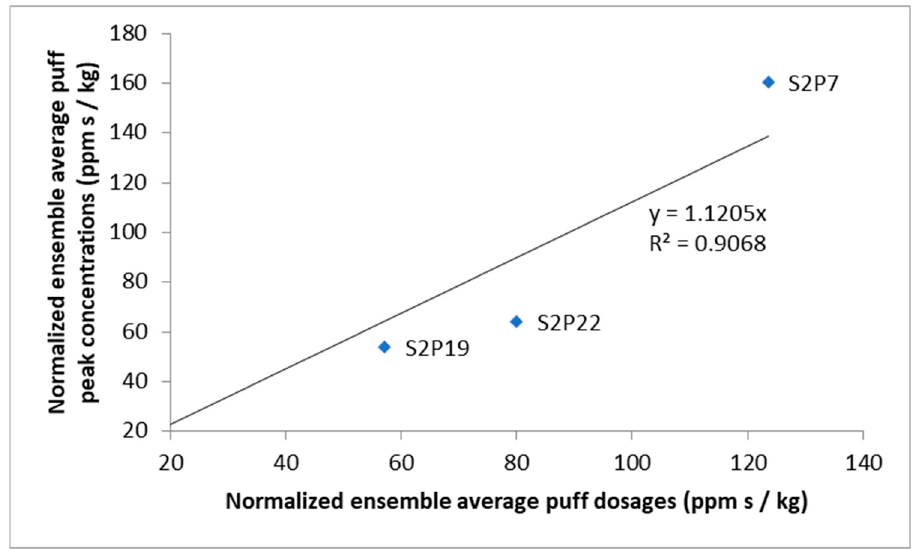
Figure 5. Puff releases: ensemble average (m) values of peak concentrations vs. dosages.